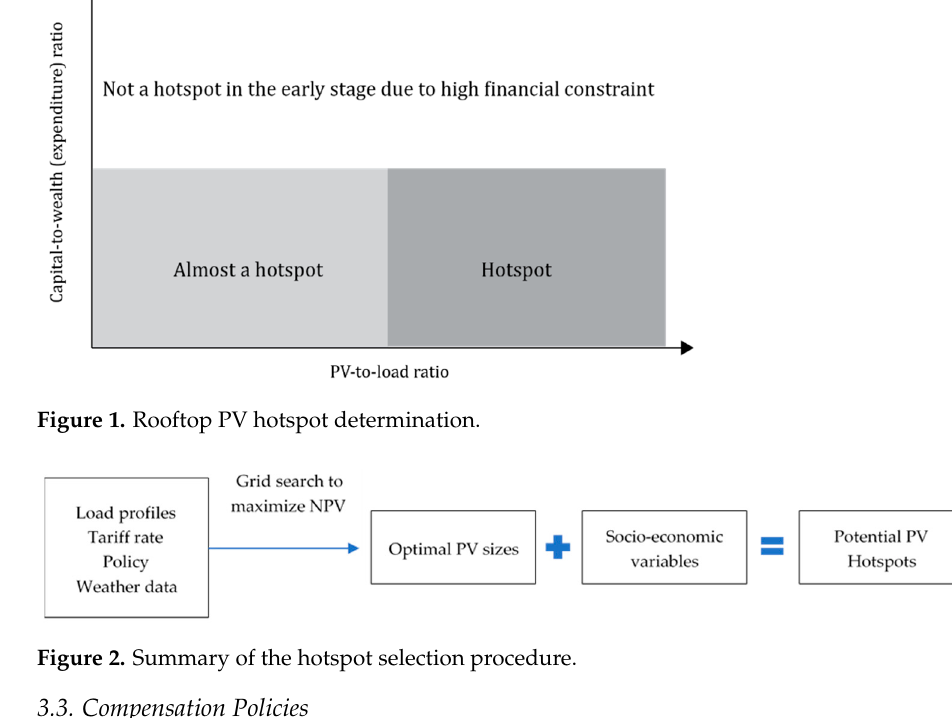
Figure 2. Summary of the hotspot selection procedure.